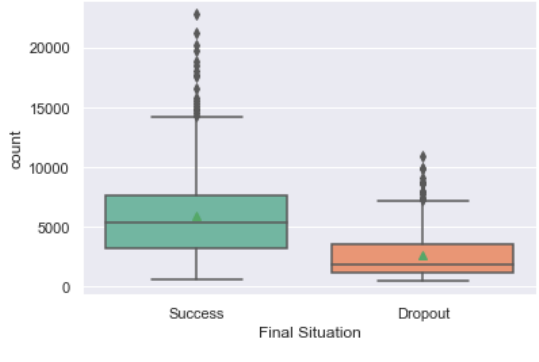
Figure 3. Boxplot success X dropout. Table 3. Features extracted to be used as input for the models.